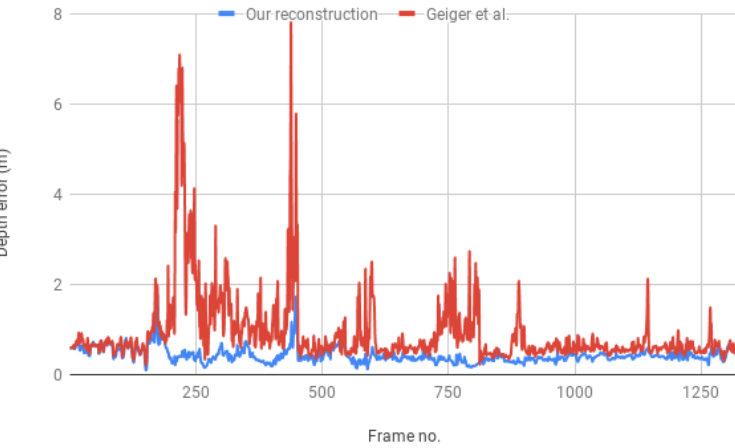
Figure 6. Average depth error of the reconstruction compared to the depth data from the structured light camera.